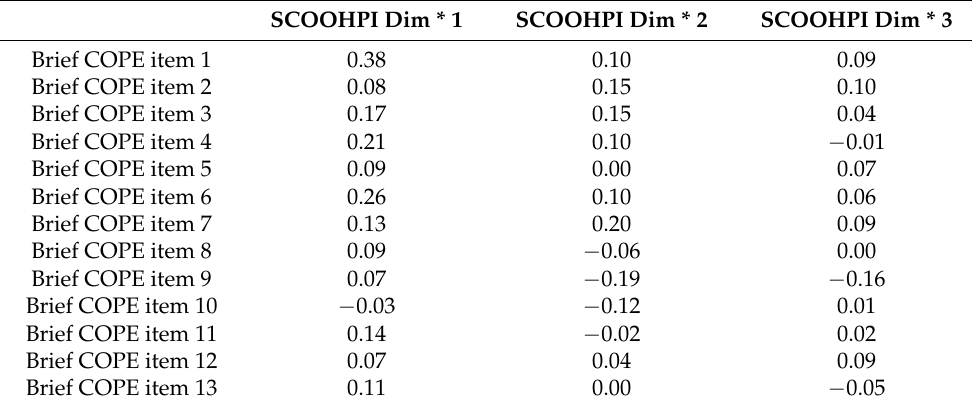
Table 7. Correlations between each dimension (SCOOHPI-Brief